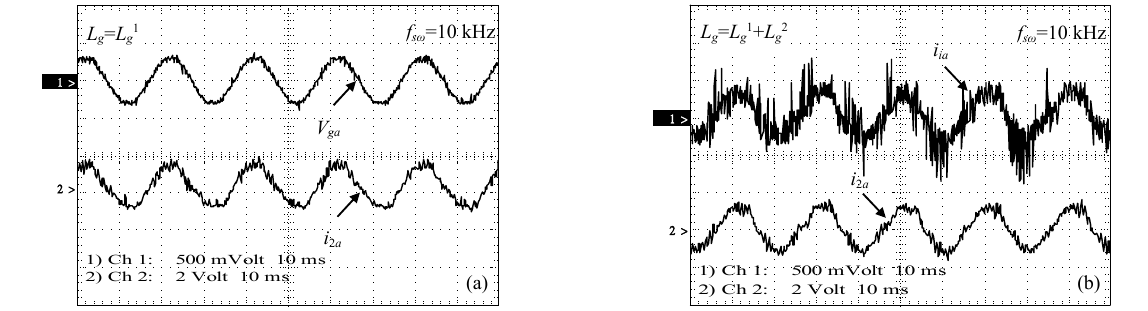
Figure 16. ( a ) Grid voltage V ga (50 V/100 mV) and current i 2a (1 A/100 mV) waveforms at steady state